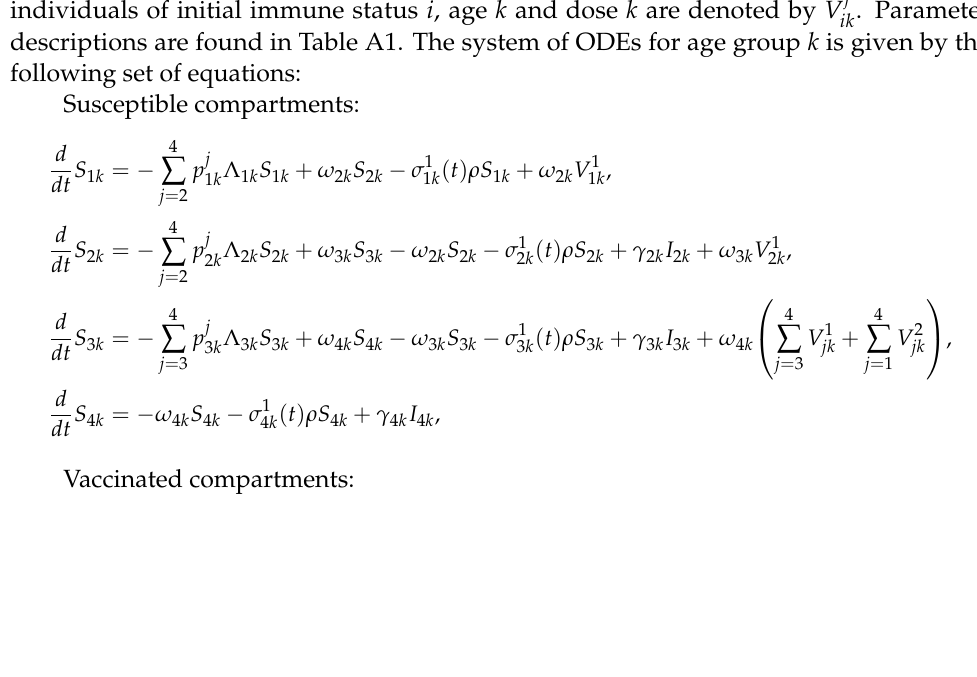
right represent vaccines 1 to 3, respectively. The vertical bar denotes the beginning of the prediction